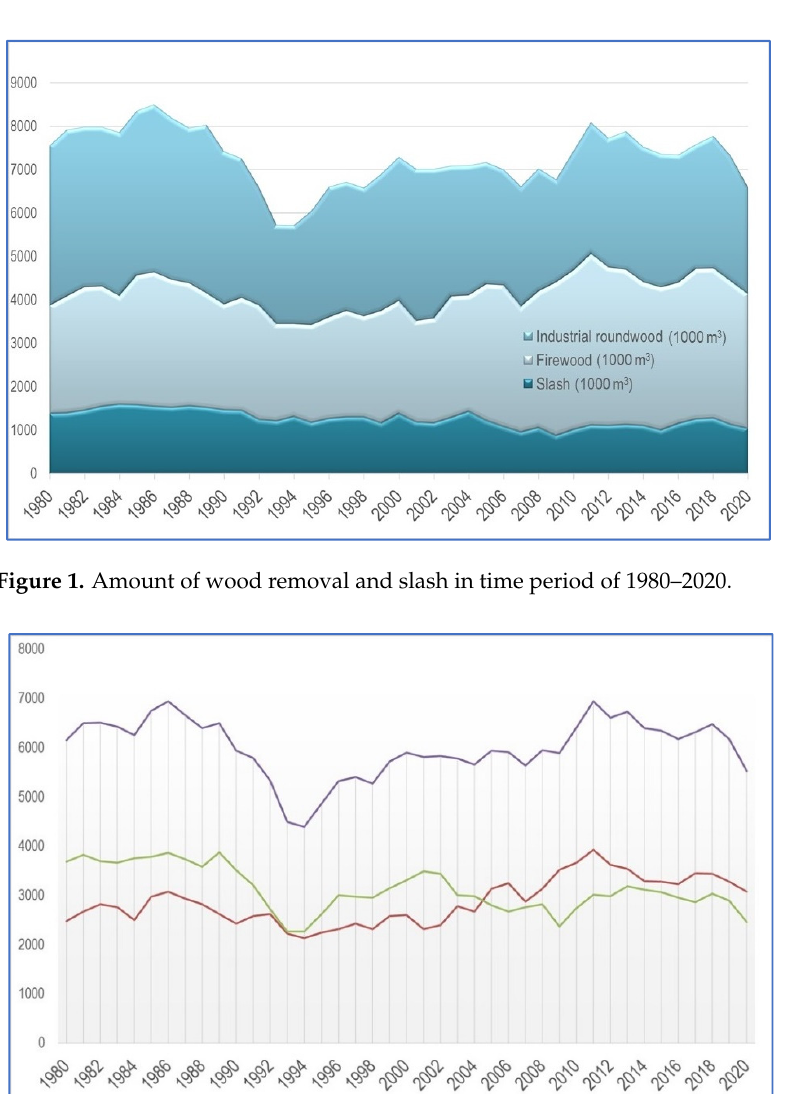
Figure 2. Amount of net roundwood, industrial wood, and firewood removed from forests in time period of 1980–2020.